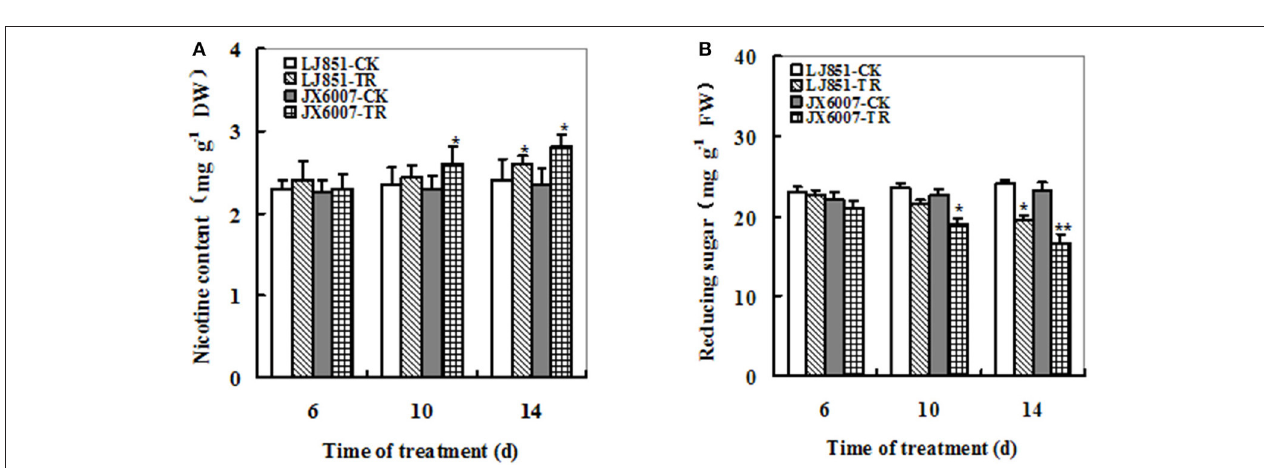
FIGURE 4 | Dynamic changes of Nicotine (A) and Reducing sugar (B) contents in both types of flue-cured tobacco plants during 14 days of drought stress. LJ851-CK stands for LJ851 under control conditions; LJ851-TR stands for LJ851 under drought conditions; JX6007-CK stands for JX6007 under control conditions; JX6007-TR stands for JX6007 under drought conditions. Bar indicates SE. * t -test, with P < 0.05; ** t -test, with P <